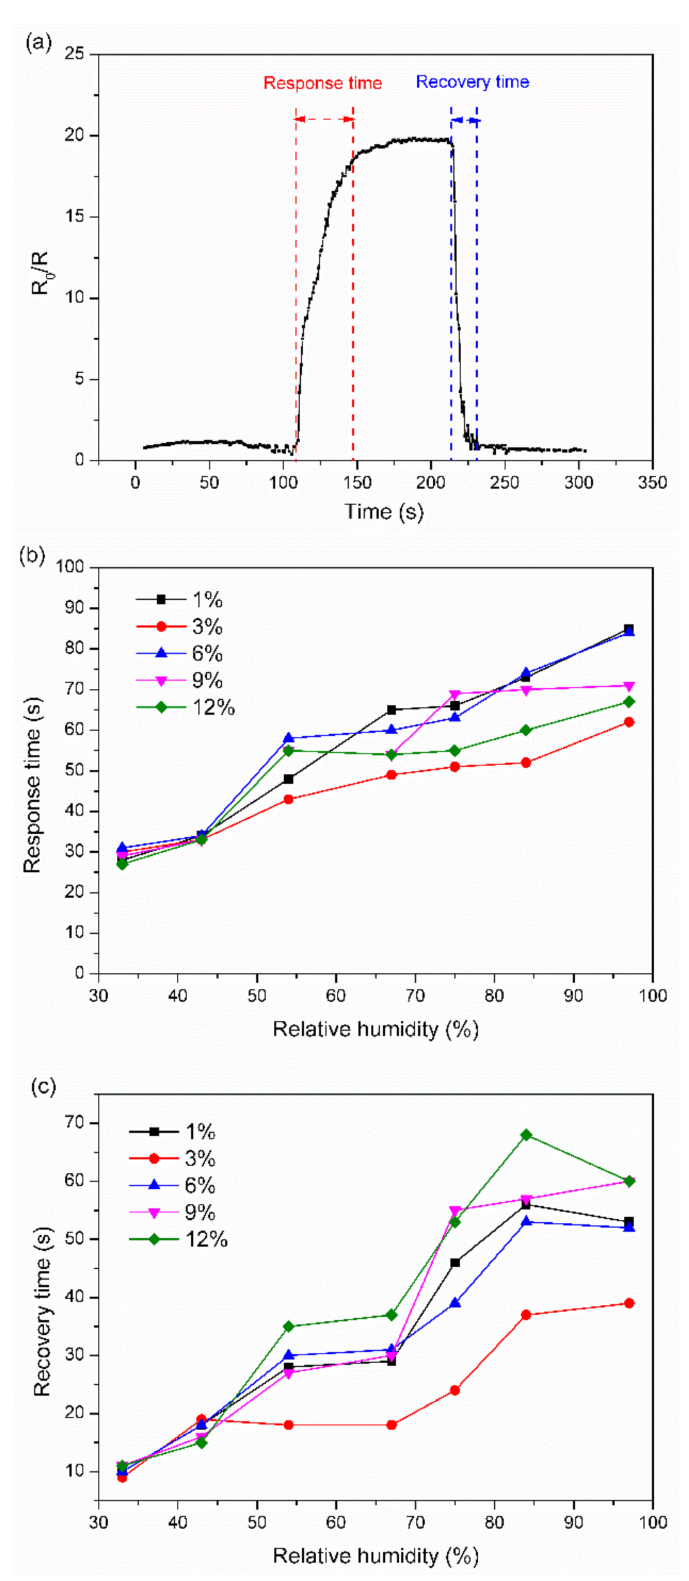
Figure 5. ( a ) Response-time curve of the 6% TiNP/CNC-based humidity sensors to 43% RH, ( b ) response time, and ( c ) recovery time of TiNP/CNC-based humidity sensors following expo- sure to 33–97%